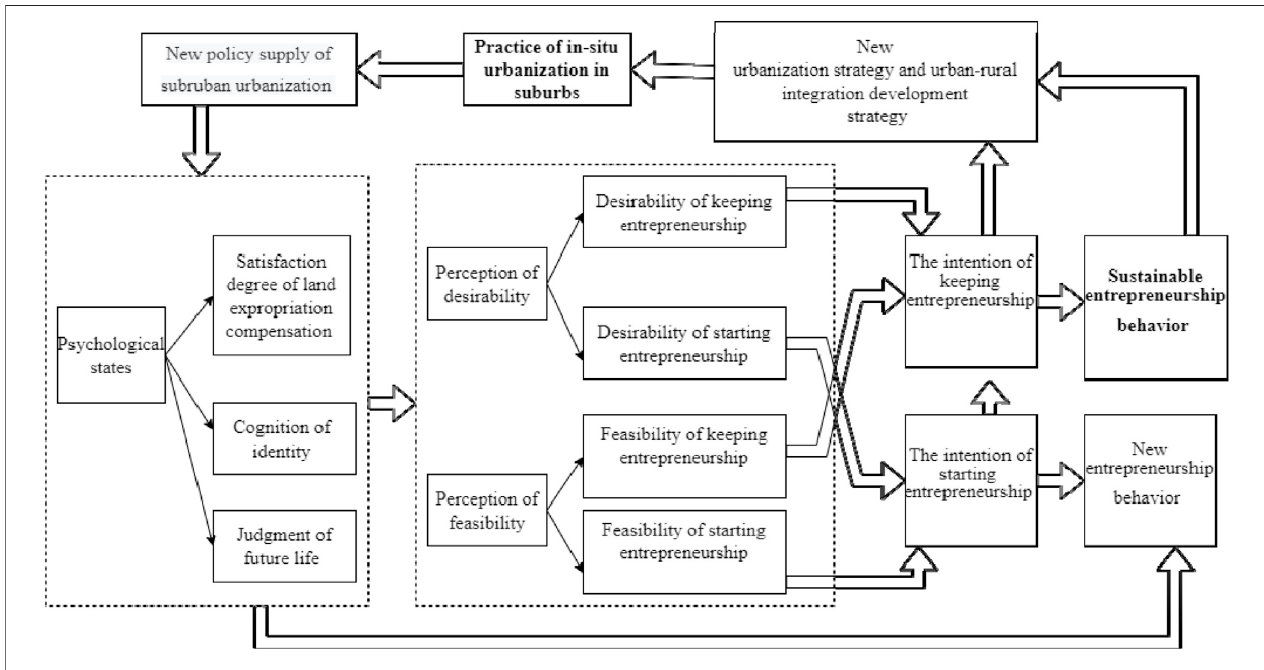
FIGURE 1 | Conceptual model for sustainable entrepreneurship of land-lost